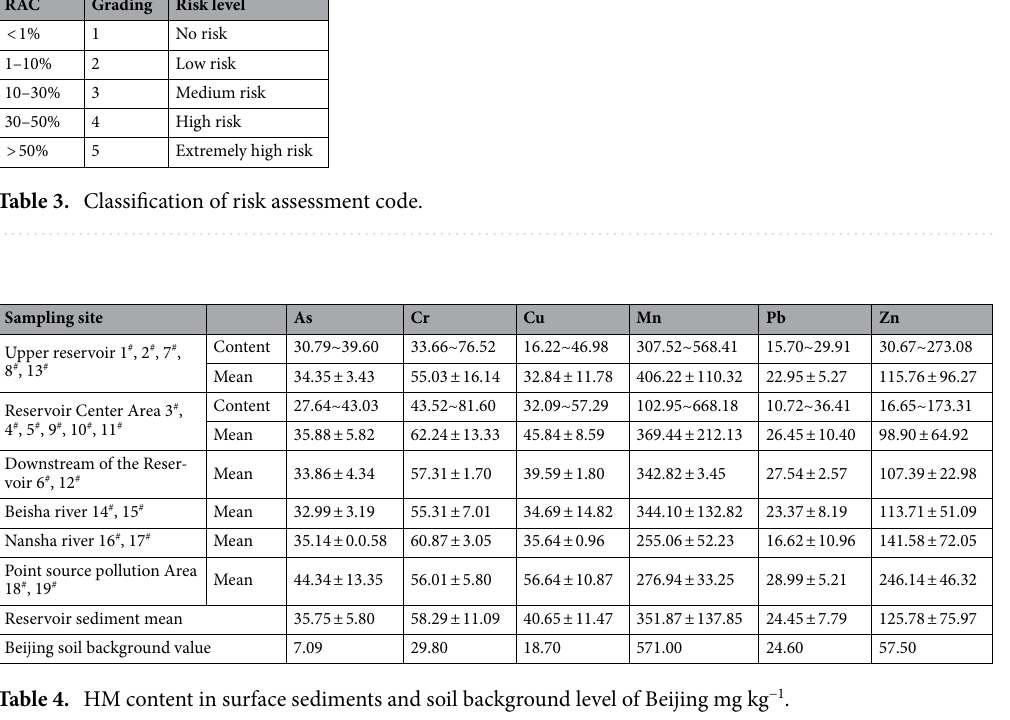
Table 4. HM content in surface sediments and soil background level of Beijing mg kg −1 .